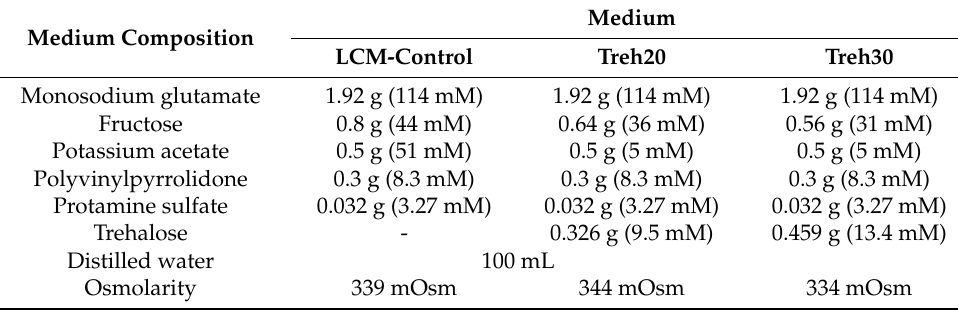
Table 1. Composition of cryoprotective media for dilution of rooster